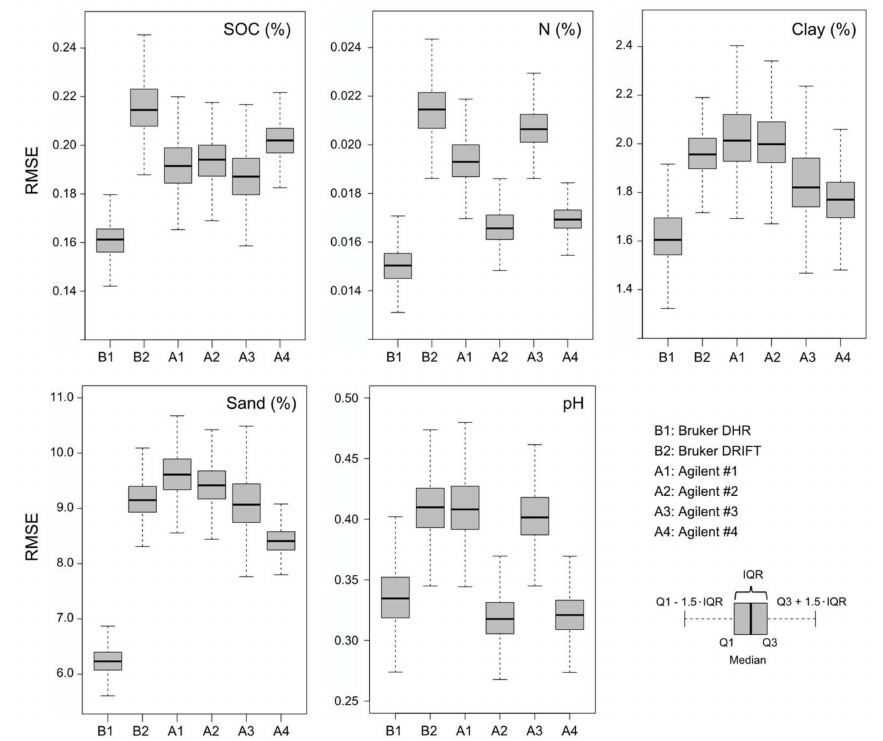
Figure 4. Distributions of RMSE values across repeated 10-fold CV PLS runs for SOC, N, clay content, sand content and pH values for all measured